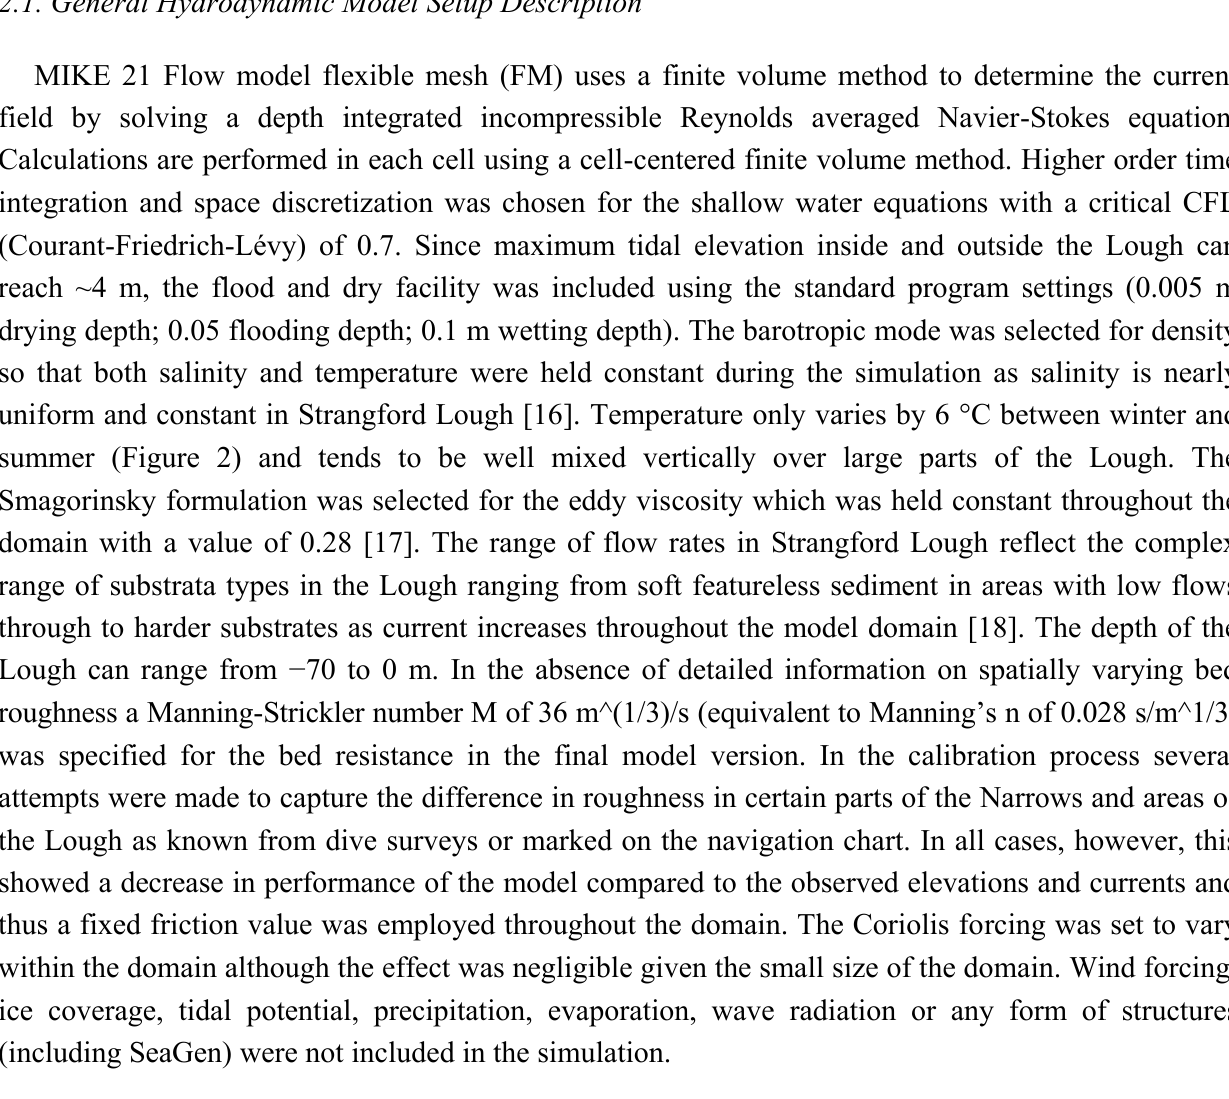
Figure 2. Observed seawater temperature (°C) from June 2011 to December 2012 obtained from the Portaferry Quay Aqualogger